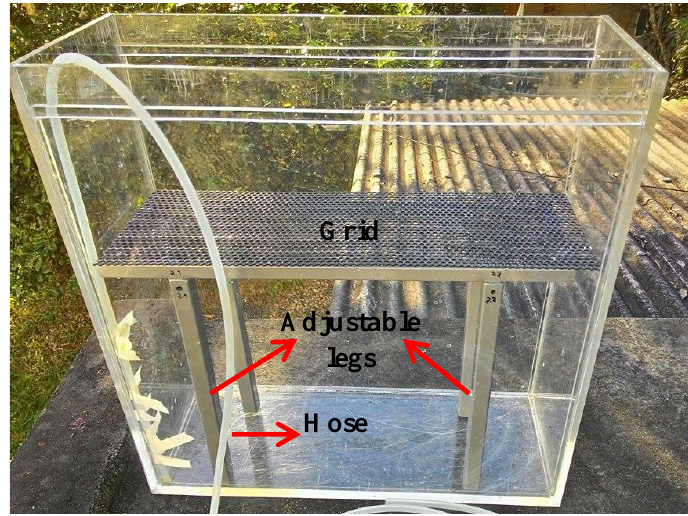
Figure 2. Box system used to place the models.